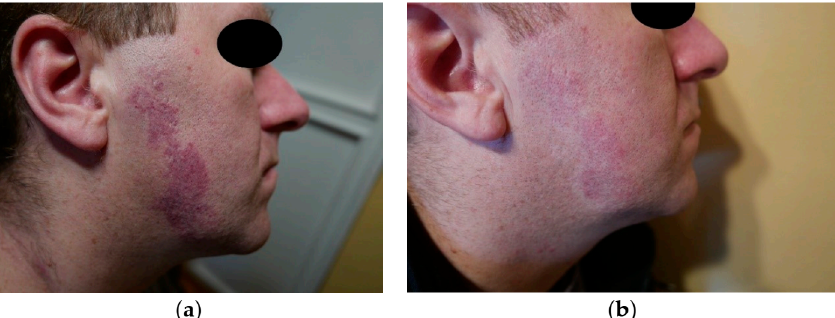
Figure 4. Red PWS on the cheek: ( a ) before treatment and ( b ) after treatment (estimated at 9 points).